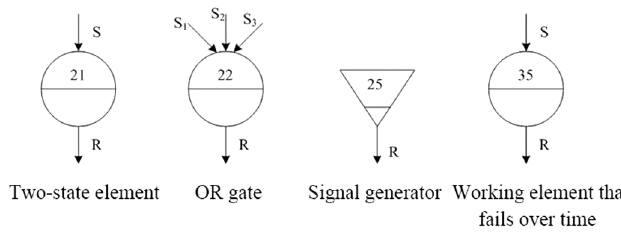
Fig. 1. GO-FLOW modeling operators.